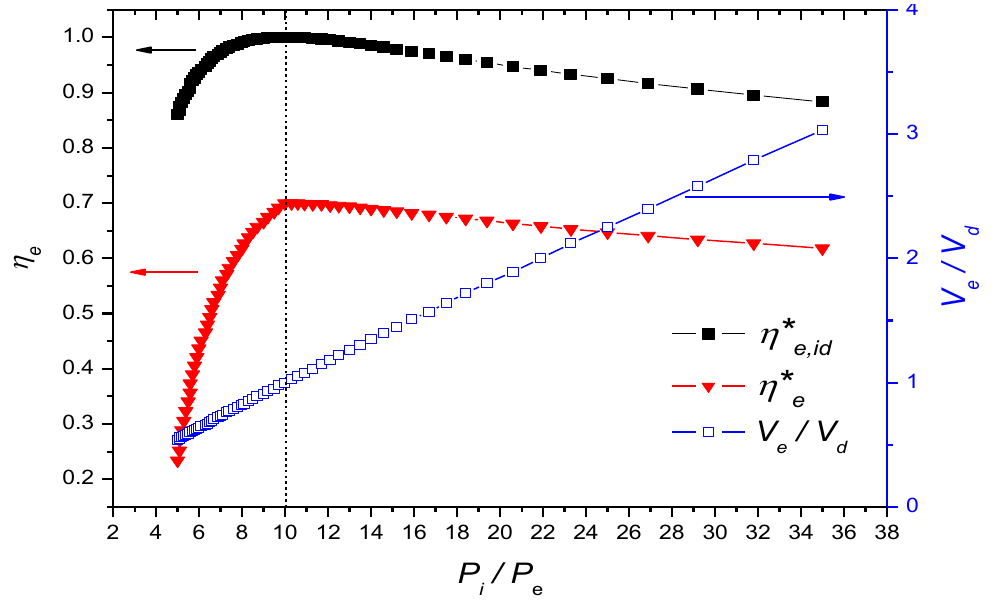
Figure 5. Effective expansion efficiency with imposed pressure ratio in the HT